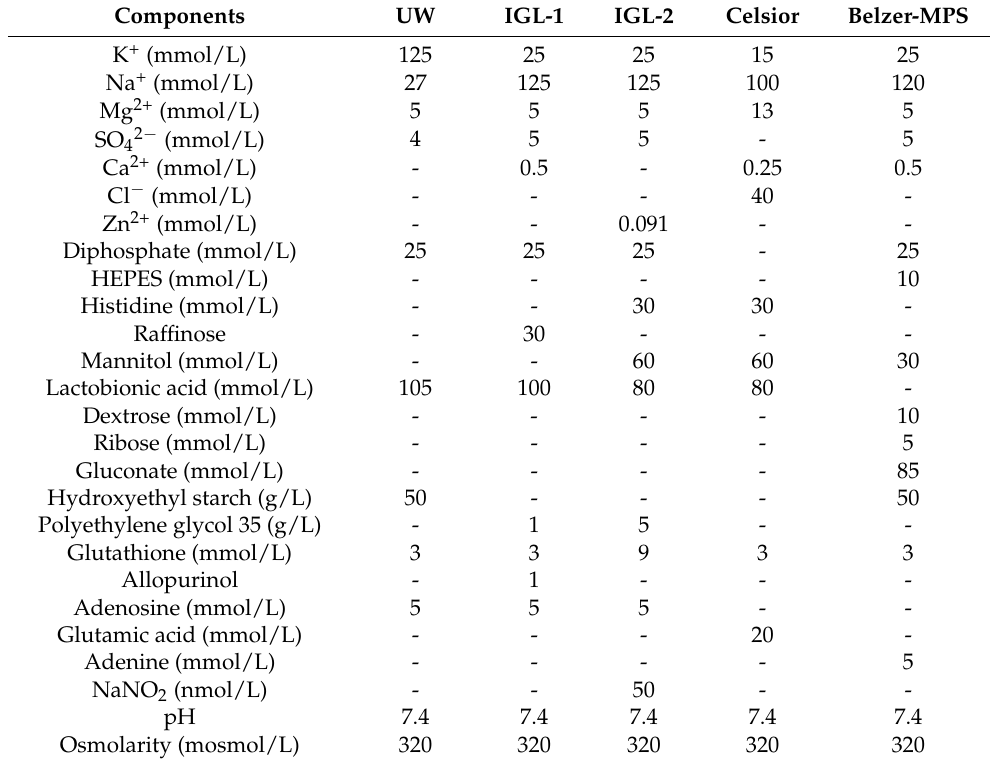
Table 1. Static Cold Storage and Dynamic preservation solutions compositions.